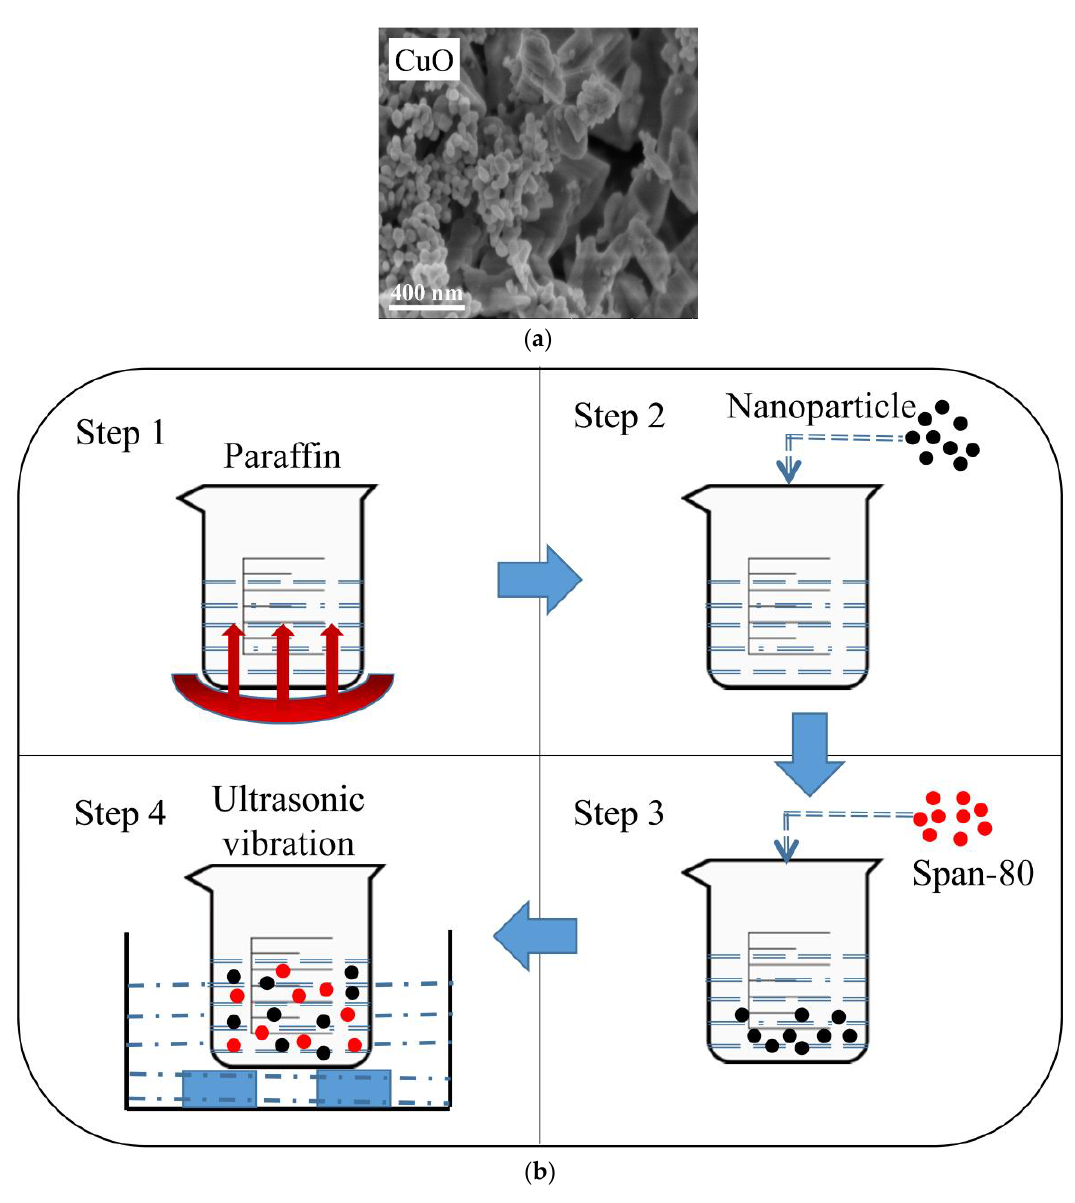
Figure 1. SEM of the nanoparticle CuO and scheme for composite preparation: ( a ) CuO nanoparticles and ( b ) preparation procedure of nanocomposite phase-change materials (PCMs).